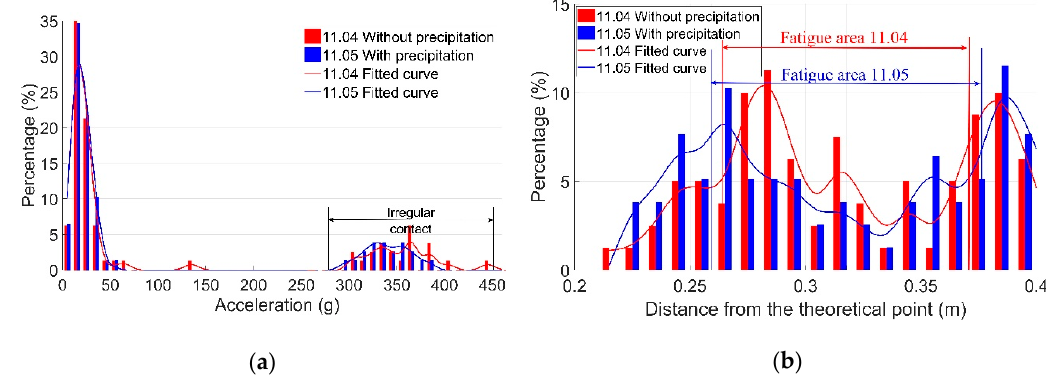
Figure 17. Influence of precipitation on the dynamic responses. ( a ) Vertical acceleration distribution; ( b ) fatigue area analysis.